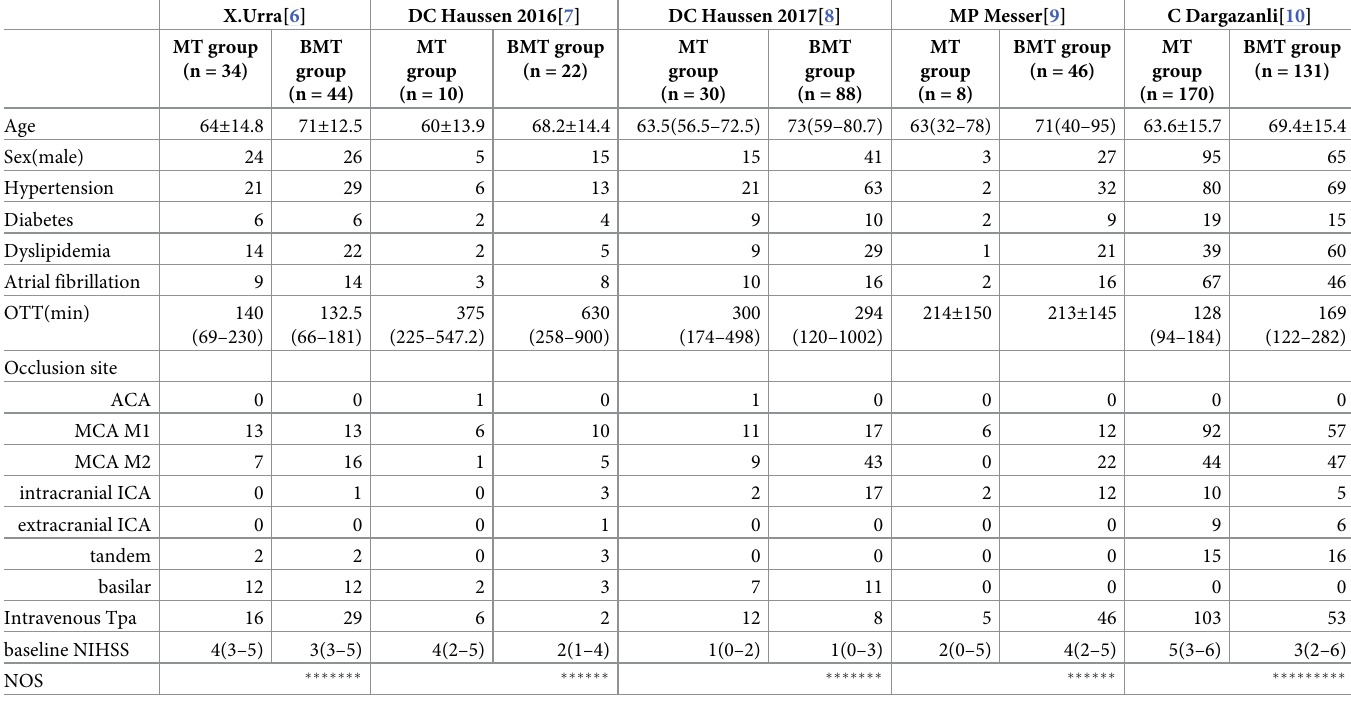
Table 1. Characteristics of the patients in the included